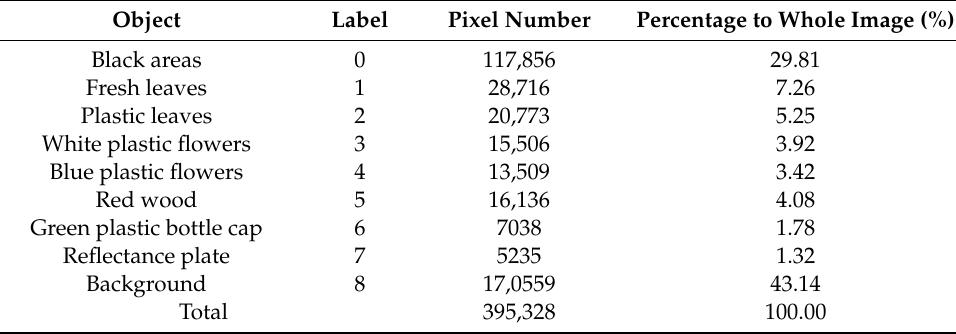
Figure 6. Label image of the active Hyperspectral imaging (HSI) data cube. Table 2. Labels and pixel numbers of different objects in the label image.